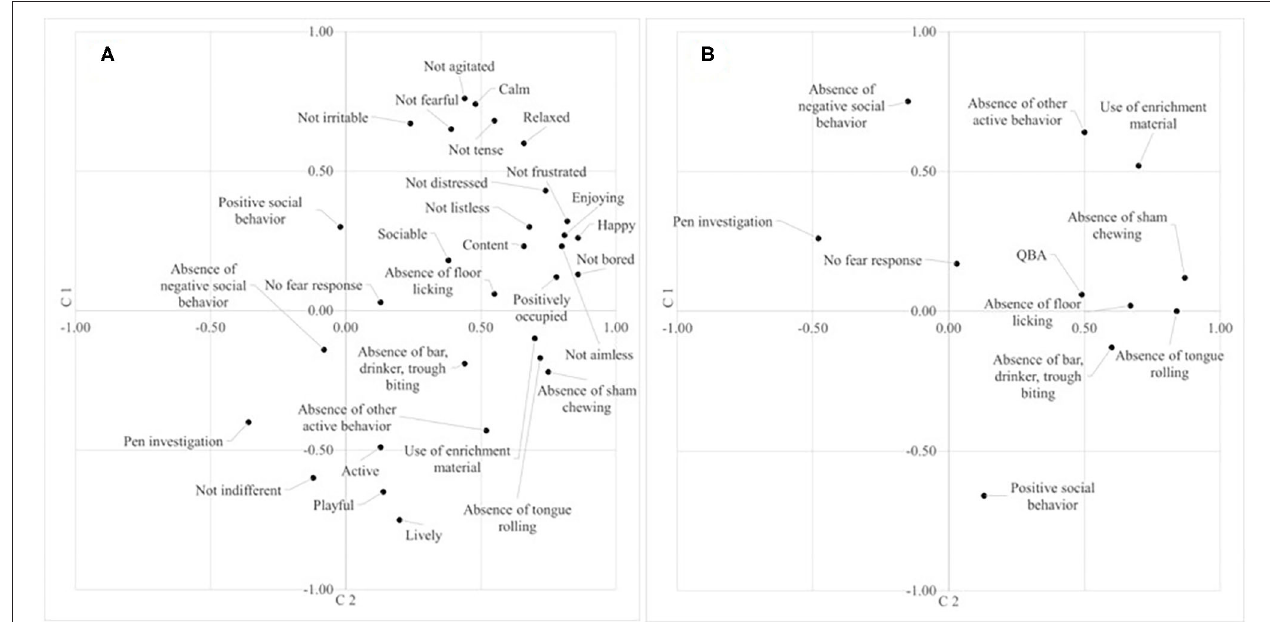
FIGURE 2 | Loadings on detected components 1 and 2 (C1, C2) of the variables of the behavioral indicators in the rotated factor pattern of the PCA on sows’ behavior, compromising (A) solution with adjectives of the Qualitative Behavior Assessment (QBA) as independent variables, (B) solution with adjectives of the QBA pre-aggregated using the weights and calculation rules defined in the Welfare Quality ® protocol for fattening pigs ( Welfare Quality®,